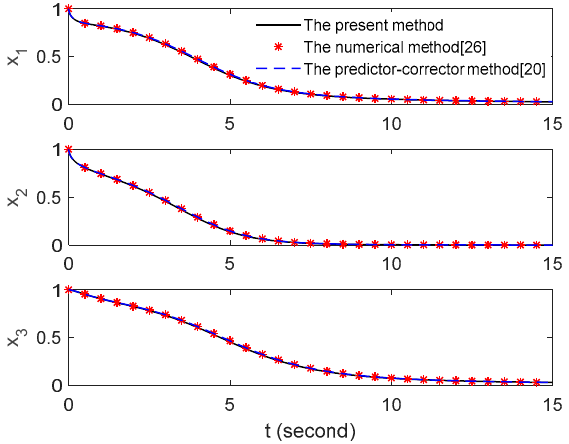
Figure 7. Numerical solutions of x 1 , x 2 and x 3 for the case of h = 0.001.